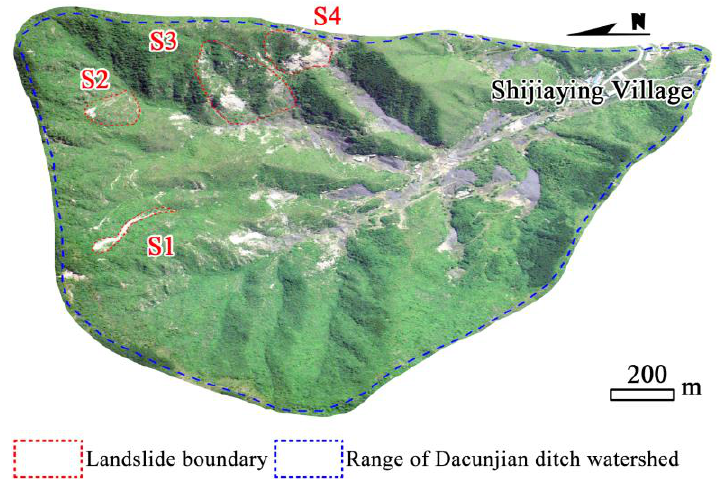
Figure 21. 3D map of Dacunjian Ditch.